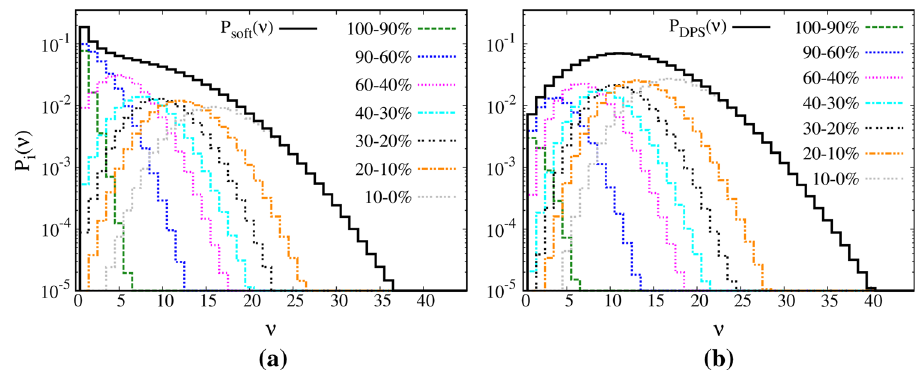
pretty small, and we will neglect its residual dependence on impact